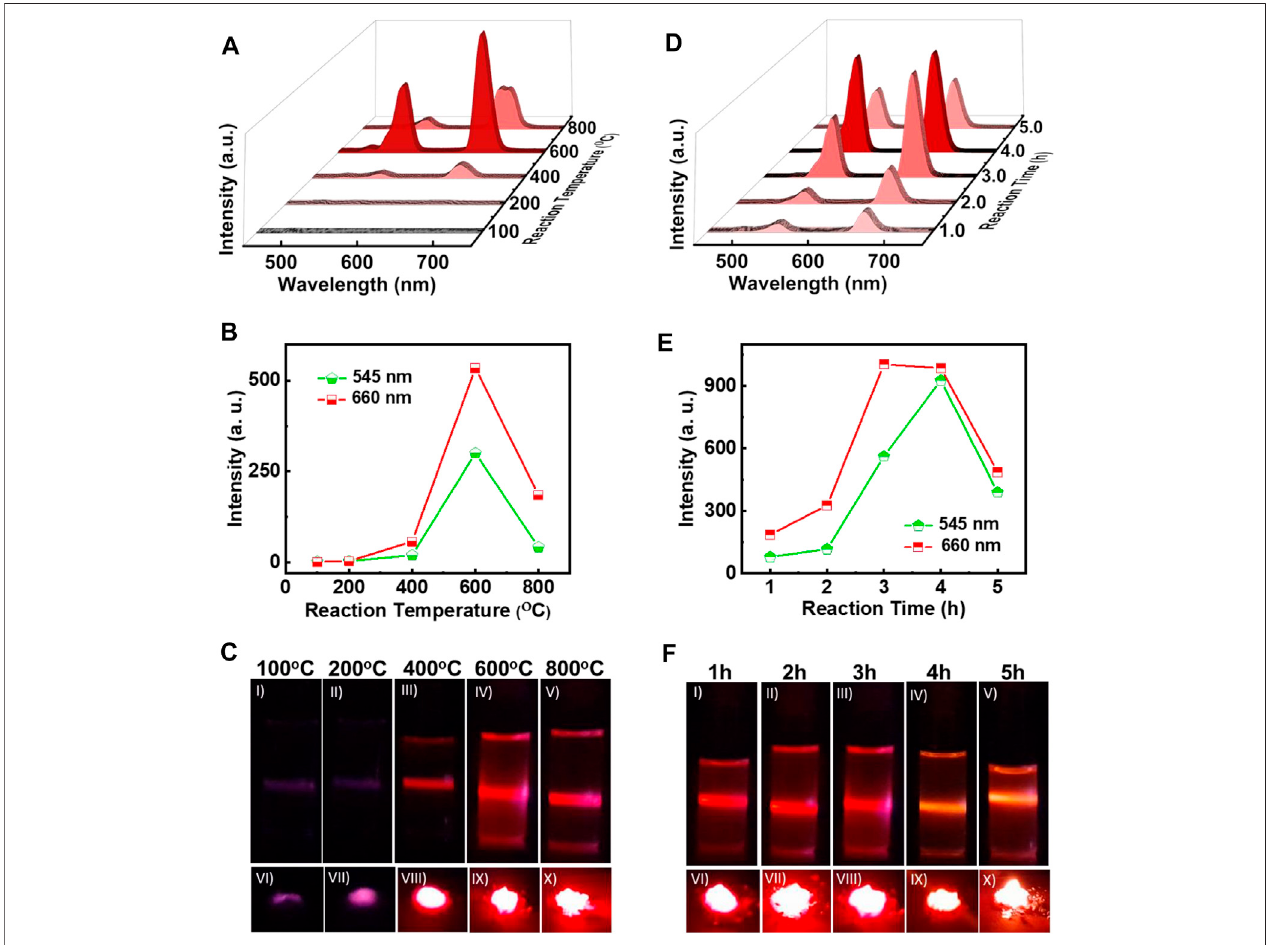
FIGURE 2 | (A) UCL spectra, (B) plot of intensity variation of green and red emission peaks, and (C) photographic images of ligand free NaYF 4 :Yb/Er UCNPs synthesized at different reaction temperatures for a reaction time of 3 h (D) UCL spectra, (E) plot of intensity variation of green and red emission peaks, and (F) photographicimagesofligandfreeUCNPssynthesizedforareactionat600 ° Cwithvaryingreactiontimes.PhotographicimagesI-Vdepictsthecolloidalsolutions(1 mg/ ml in ethanol) and VI-X portrays the solid samples of the UCNPs under 980 nm